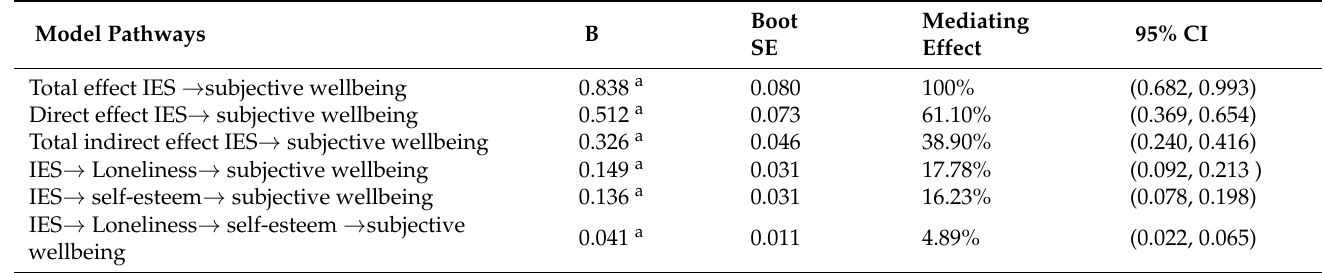
Table 4. Indirect effects of activities of intergenerational emotional support on subjective wellbeing, with loneliness and self-esteem as mediators ( n =